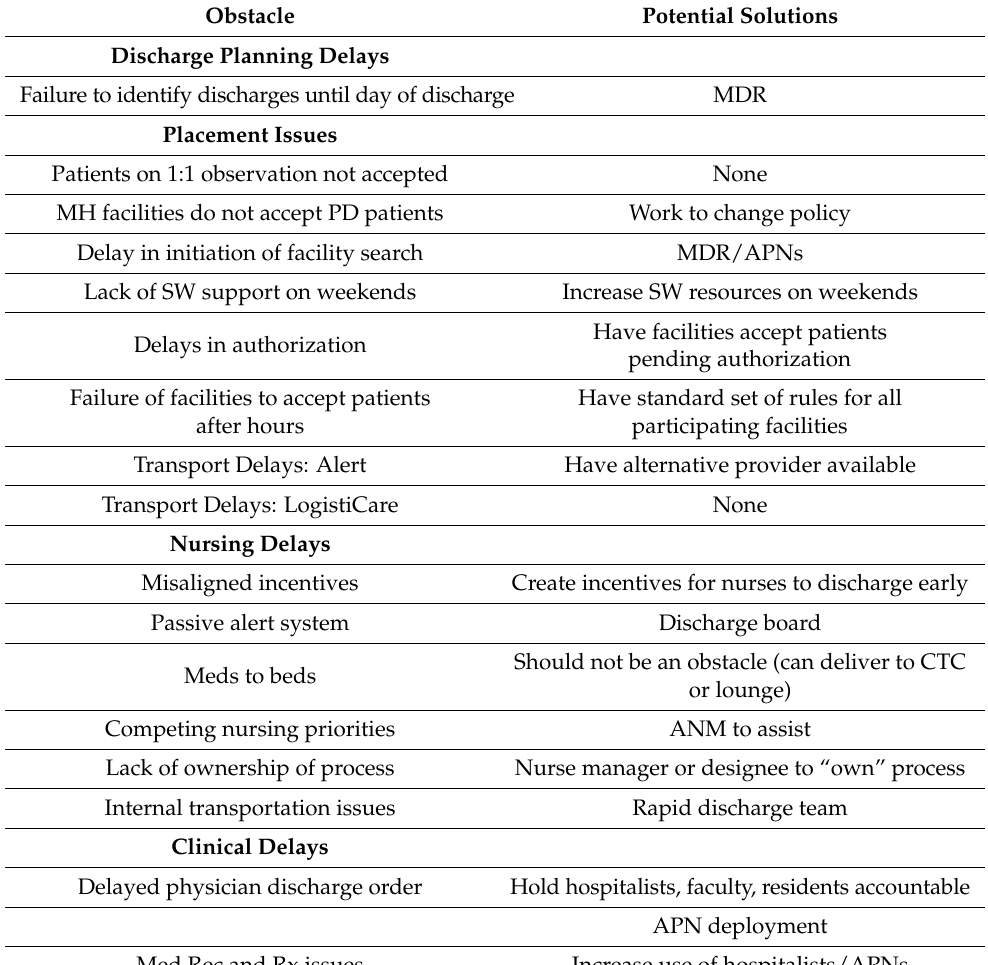
Table 2. Fishbone for discharge phase crosswalk. Abbreviations: advanced practice nurse (APN); multi-disciplinary rounds (MDRs); Meridian Health (MH); social worker (SW); assistant nurse manager (ANM); care transition center (CTC); prescription